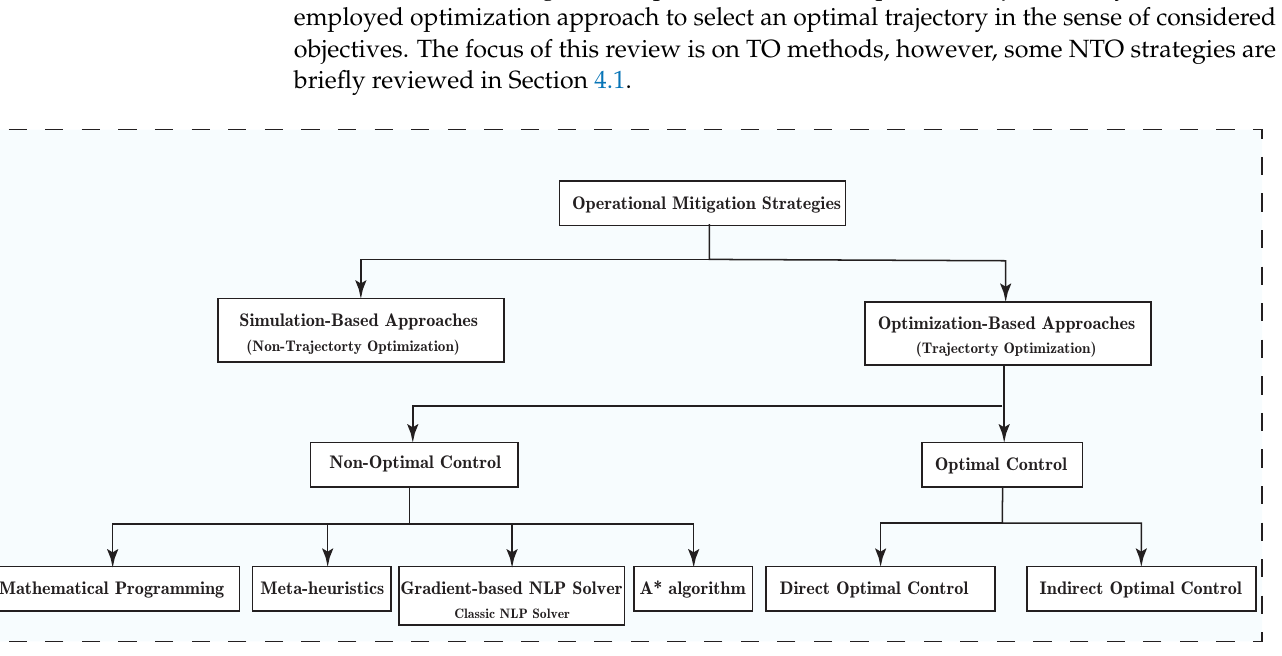
Figure 1. Classification of methods employed in the literature to mitigate the climate impact of non-CO 2